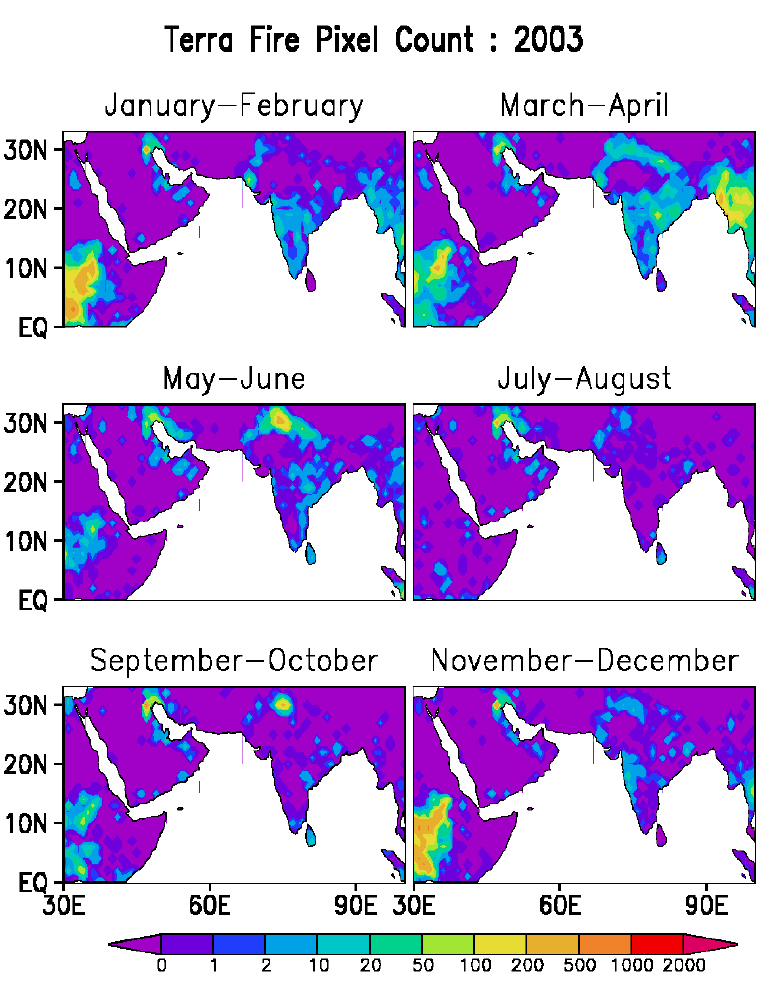
Fig. 14. Maps of fire pixel counts (from TERRA satellite data) which provide information on the period and regions of biomass